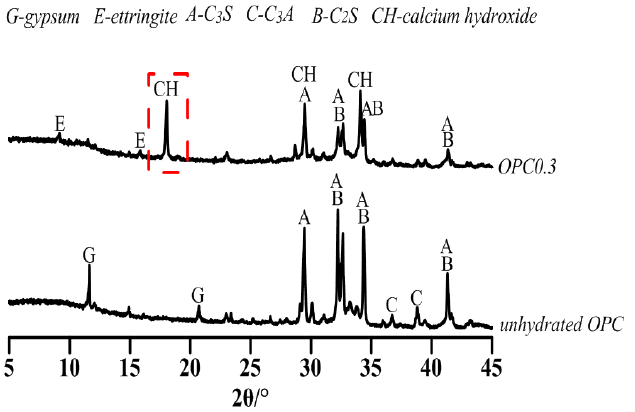
Figure 3. XRD results of OPC paste at 3 days.